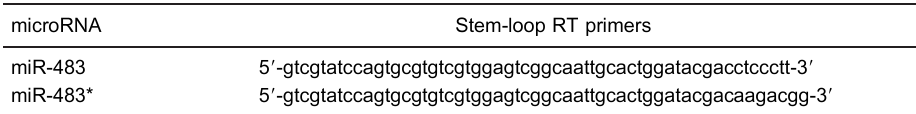
Table 1. Stem-loop RT primers of miR-cDNA.